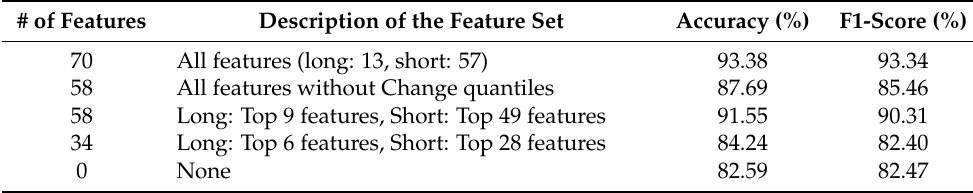
Table 6. Performance comparison of the ablation study on a significant feature